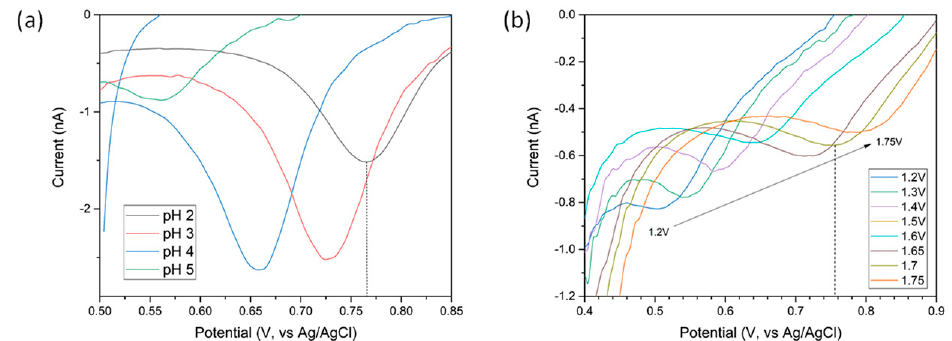
Figure 8. ( a ) Reverse sweep of cyclic voltammograms recorded in a 100 µ g/L Cu solution acidified to pH 2 to 5. The AuO/Au reduction peak occurs at 0.76 V at pH 2; ( b ) Selected regions of the cycling voltammogram of a 100 µ g/L Cu at pH 7 showing the gold oxide reduction peak when applying potentials 1.2–1.75 V to the protonator. The dashed line shows the location of the gold oxide reduction peak maximum when 1.7 V was applied to the protonator occurring at the same position as when the solution was acidified to pH 2 with acid.